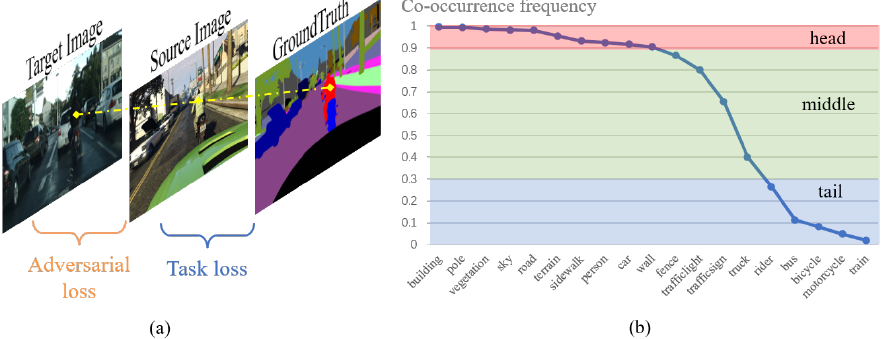
Figure 1. ( a ) A group of images during training. From left to right, they are the target image, source image, and pixel-level ground truth. ( b ) The imbalanced distribution of the co-occurrence frequency in different